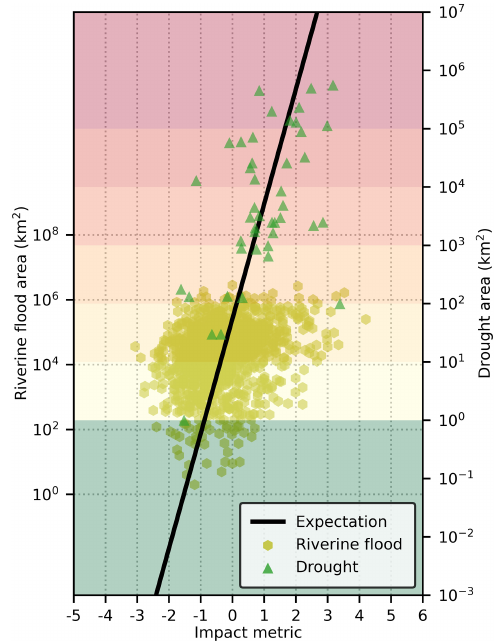
Figure 7. Riverine flood area versus drought